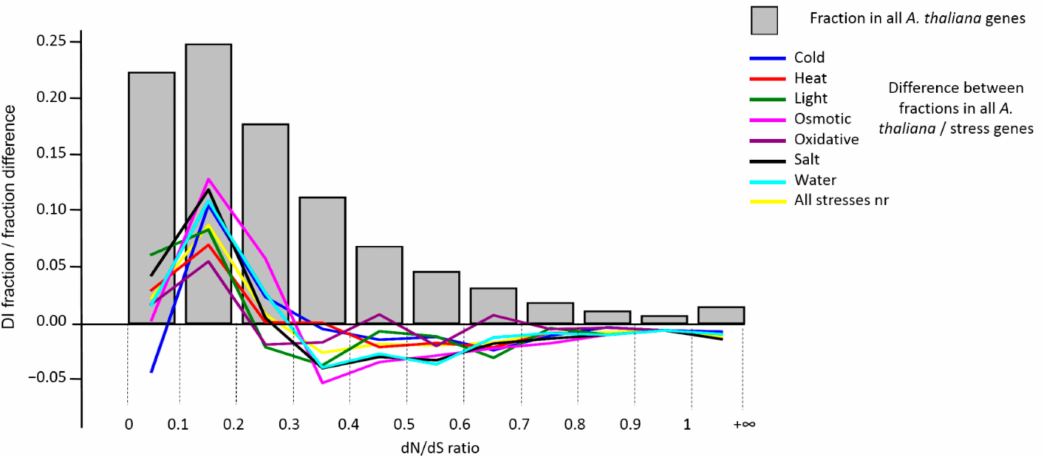
Figure 3. The distribution of frequencies of A. thaliana protein-coding genes (y-axis) by the DI value (x-axis) is shown by grey columns. Solid lines show the di ff erence between the frequencies of occurrence of DI values in the stress dataset and all A. thaliana genes. Correspondence between the line color and the stress type is shown in the box in the upper right